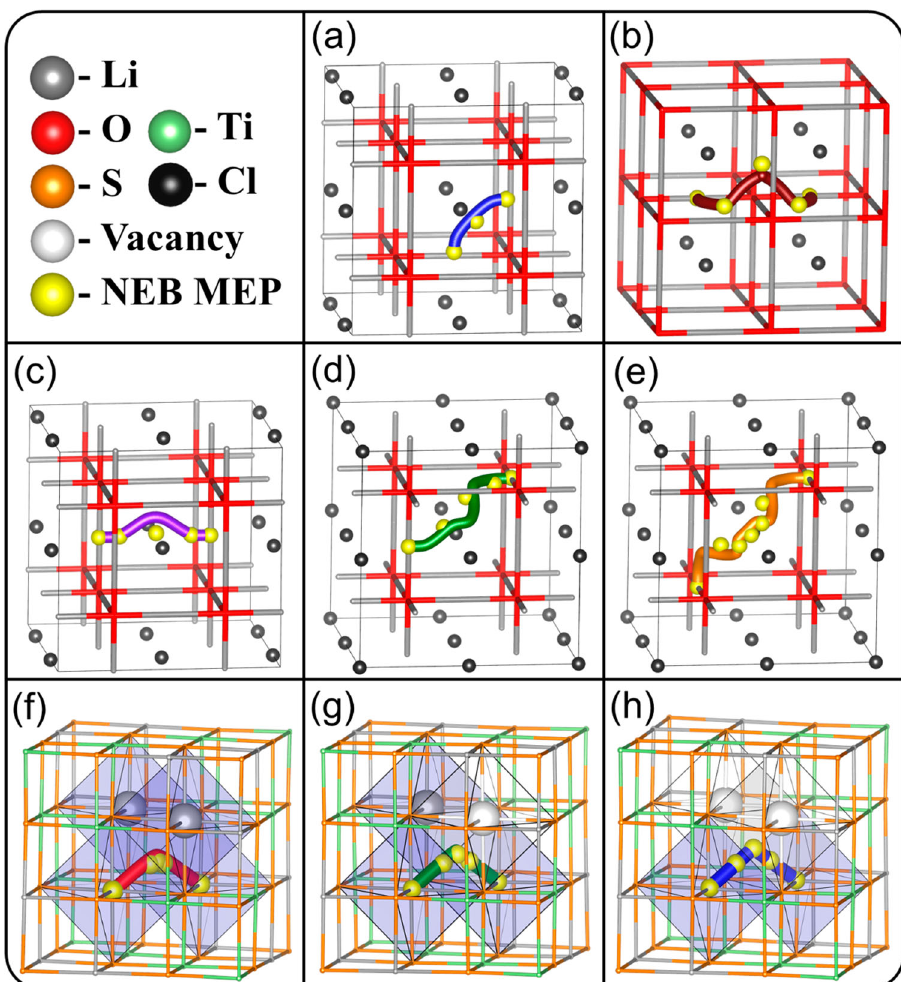
Fig. 1 Geometrical comparison between MEPs and MEDPs. The Li-ion migration trajectories computed with DFT-CI-NEB (yellow spheres) and TAPED (blue, red, green, orange, and violet wiggly curves) methods for Li 3 OCl ( a – e ) and LiTiS 2 ( f – h )